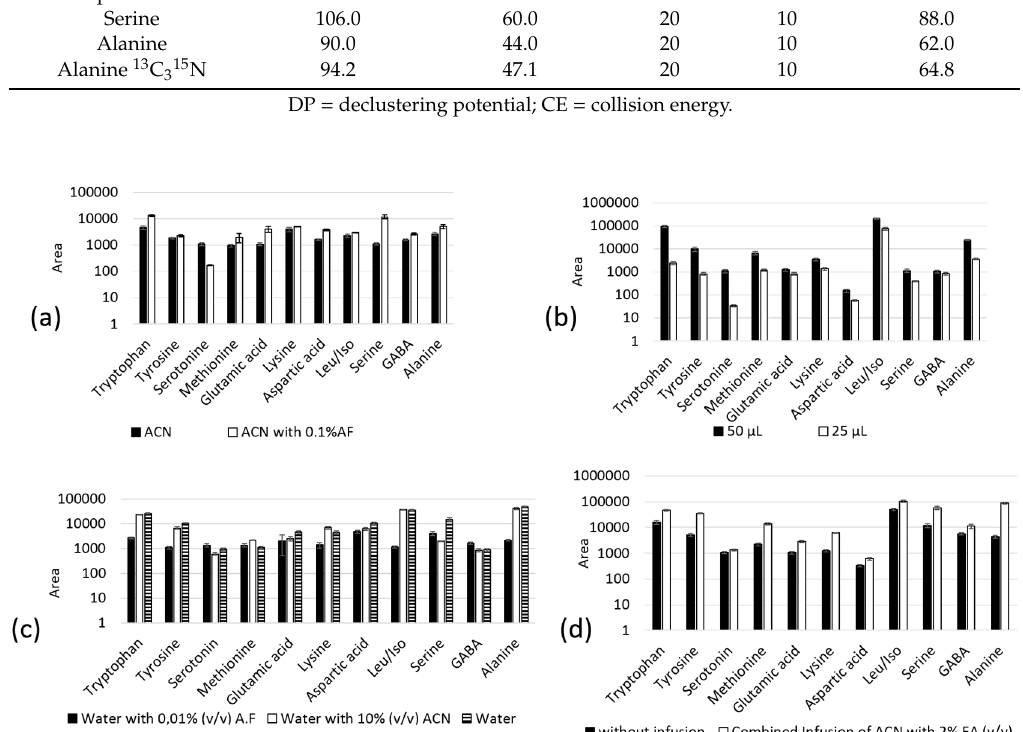
Table 2. MS/MS (SRM) ion transitions, cone energy (DP), and collision energy (CE) for each analyte.